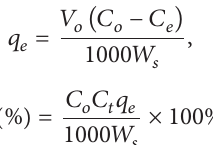
Figure 1: XRD patterns of MT, CMT, KL, and